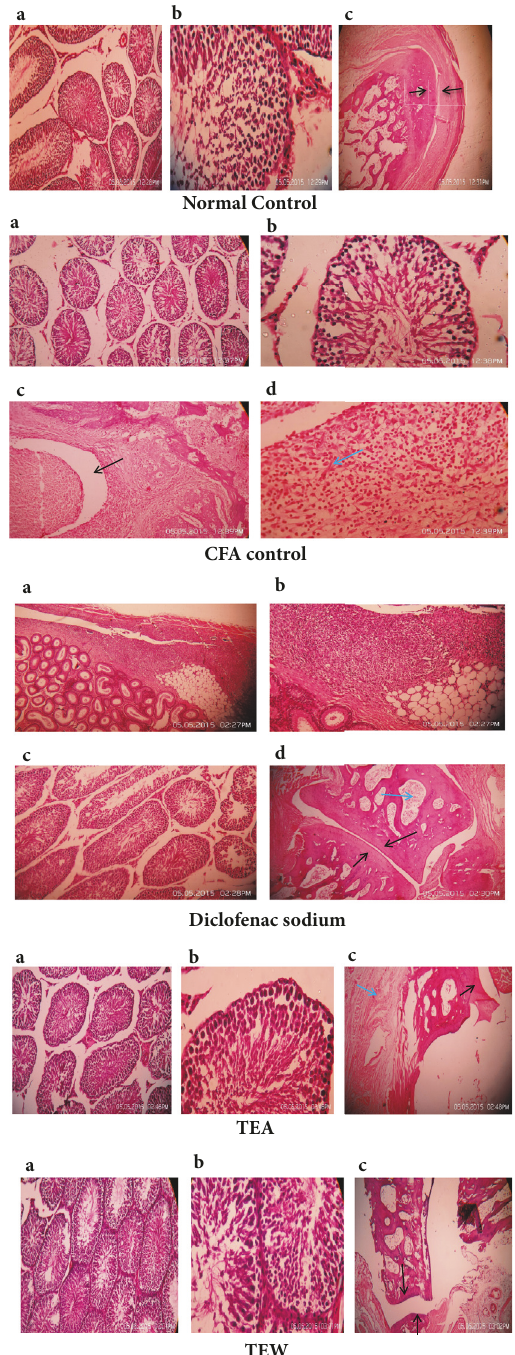
Figure 7: Effect on histopathological